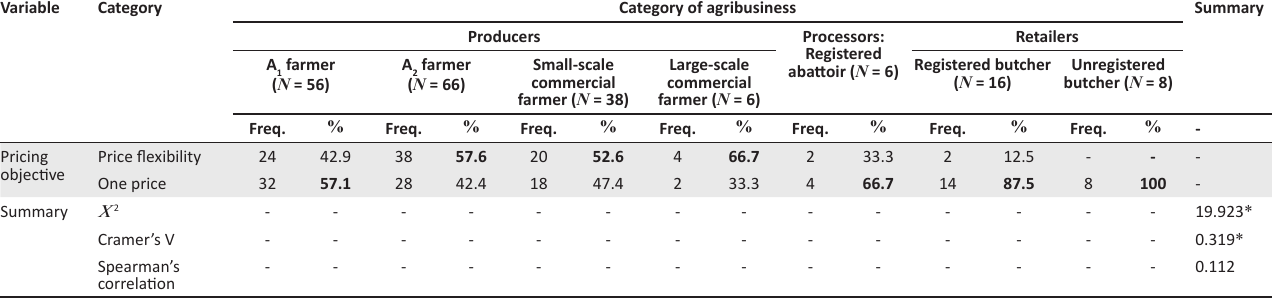
TABLE 5: Cross-tabulation of price flexibility policy and category of